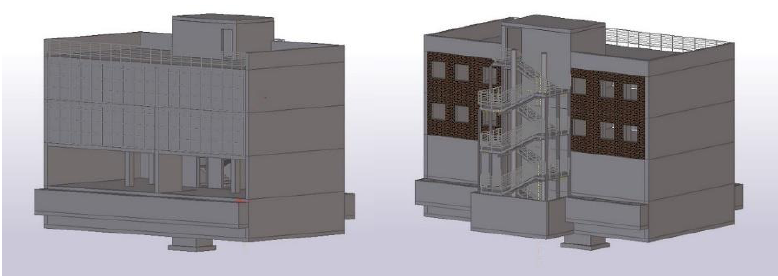
Figure 3. Front (left) and back (right) views of the sample model.